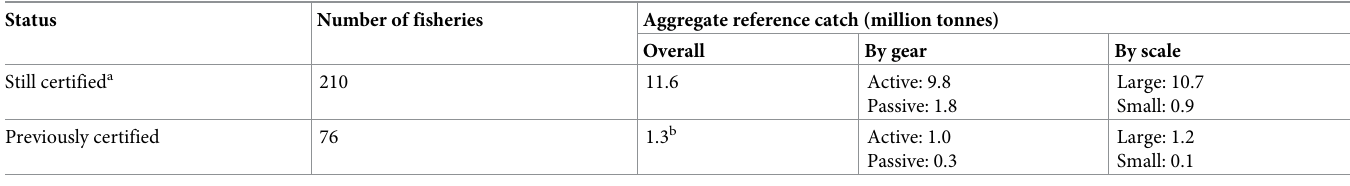
Table 4. Summary of the reference catch by gear and scale, by MSC certification